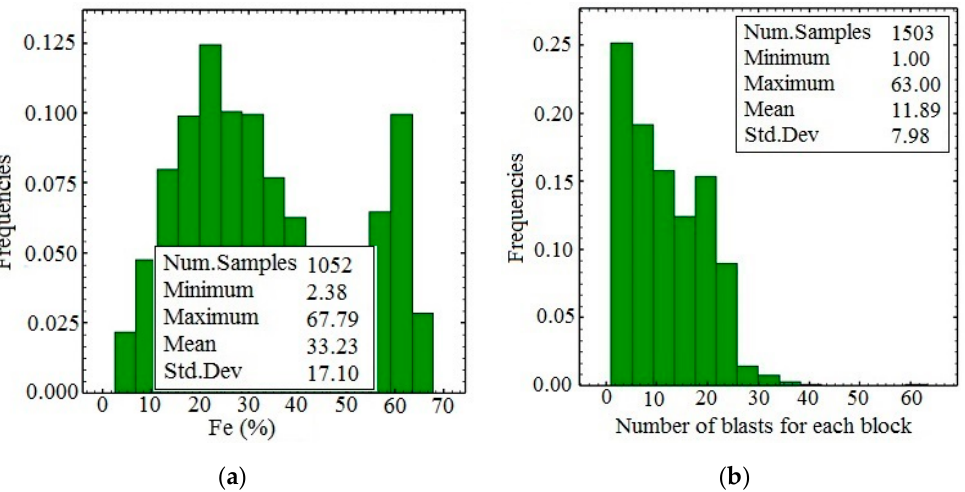
Figure 14. Histogram of true block values obtained from the mean of blastholes ( a ) and histogram of number of blastholes used for averaging the block values ( b ).